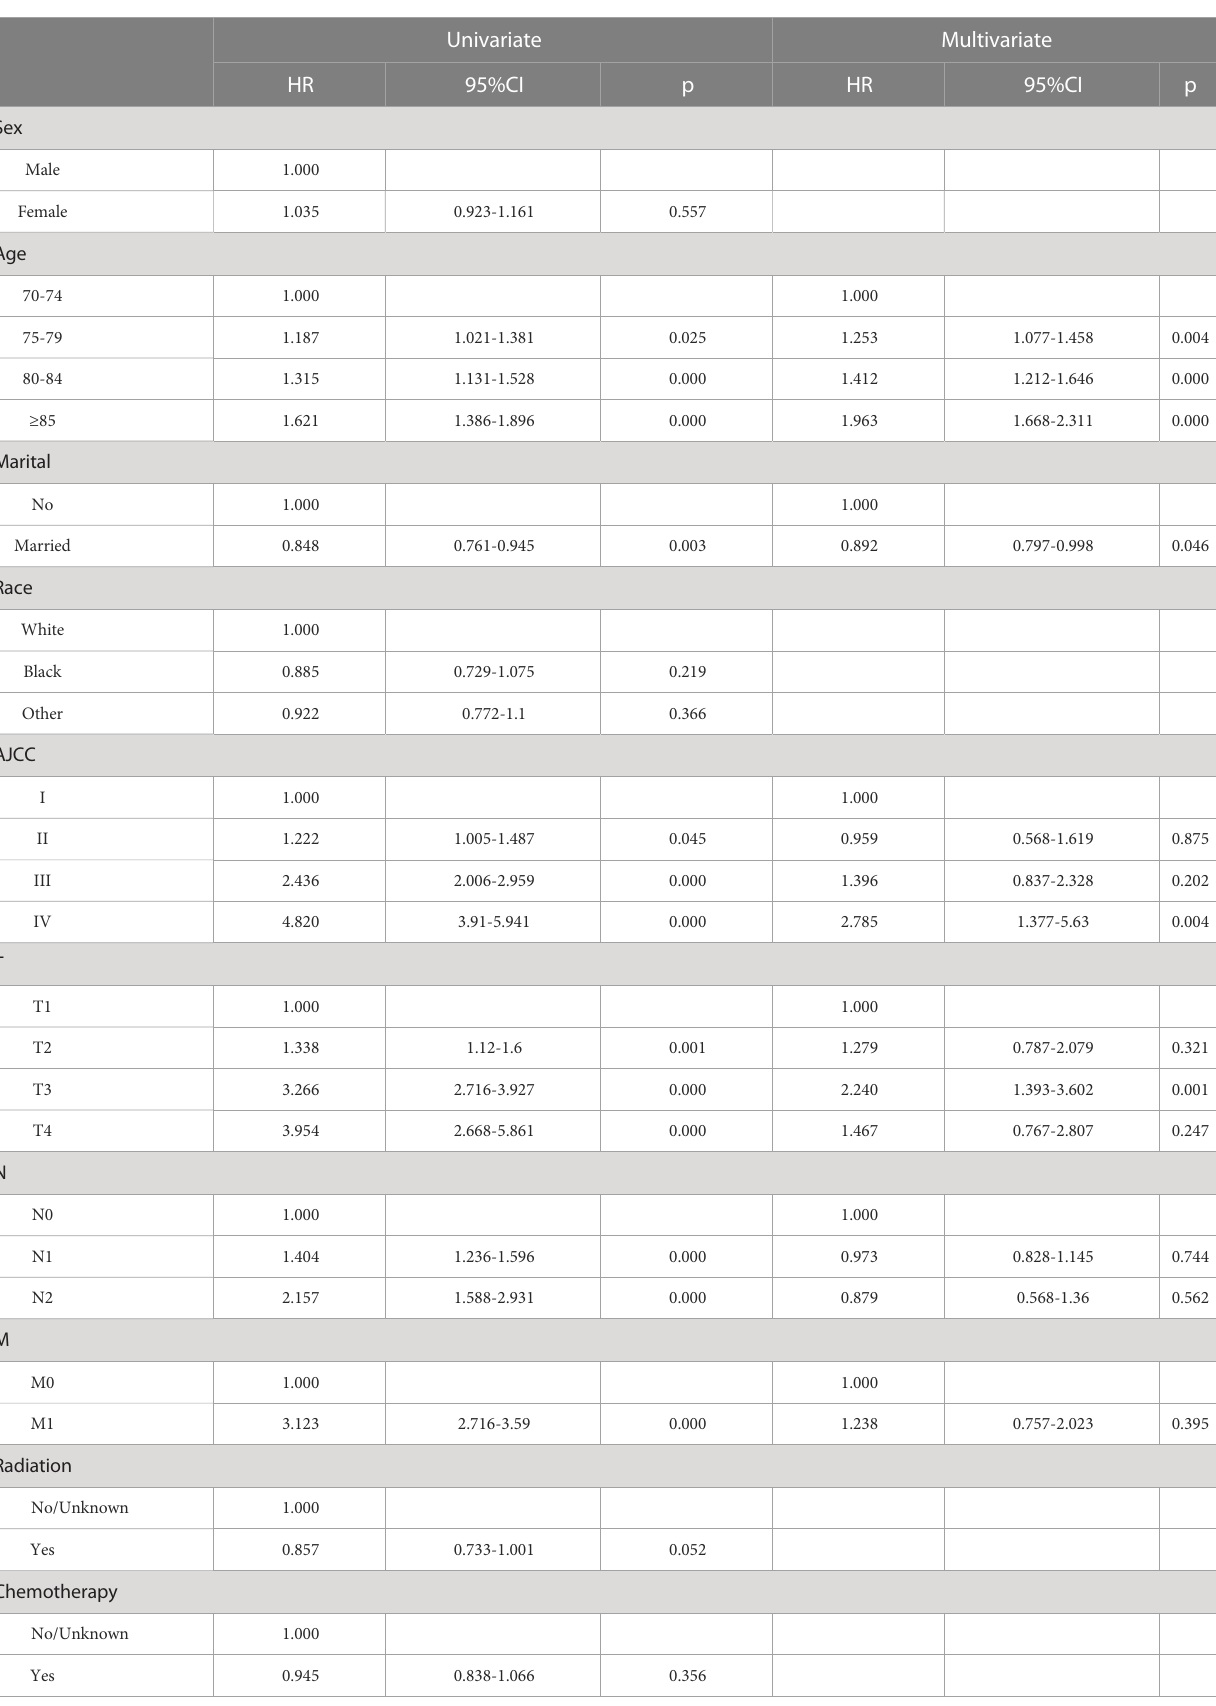
TABLE 5 Univariate and multivariate Cox regression analysis of OS for patients underwent